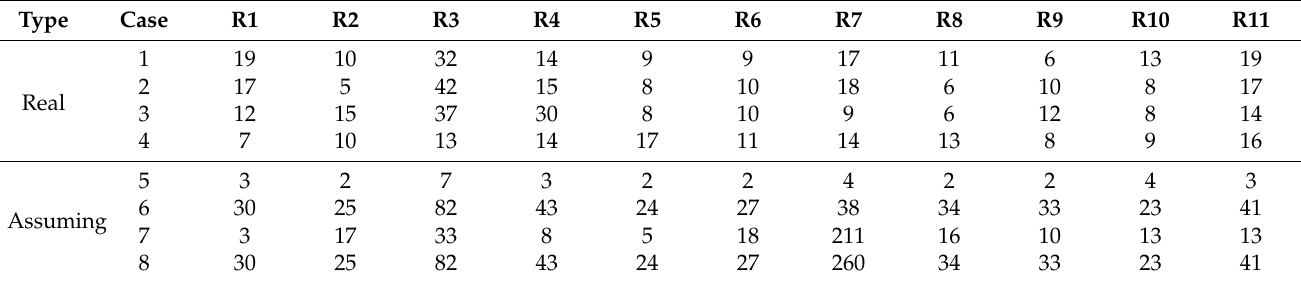
Table 8. Req-Reg cases to verify performance of GAN estimations.